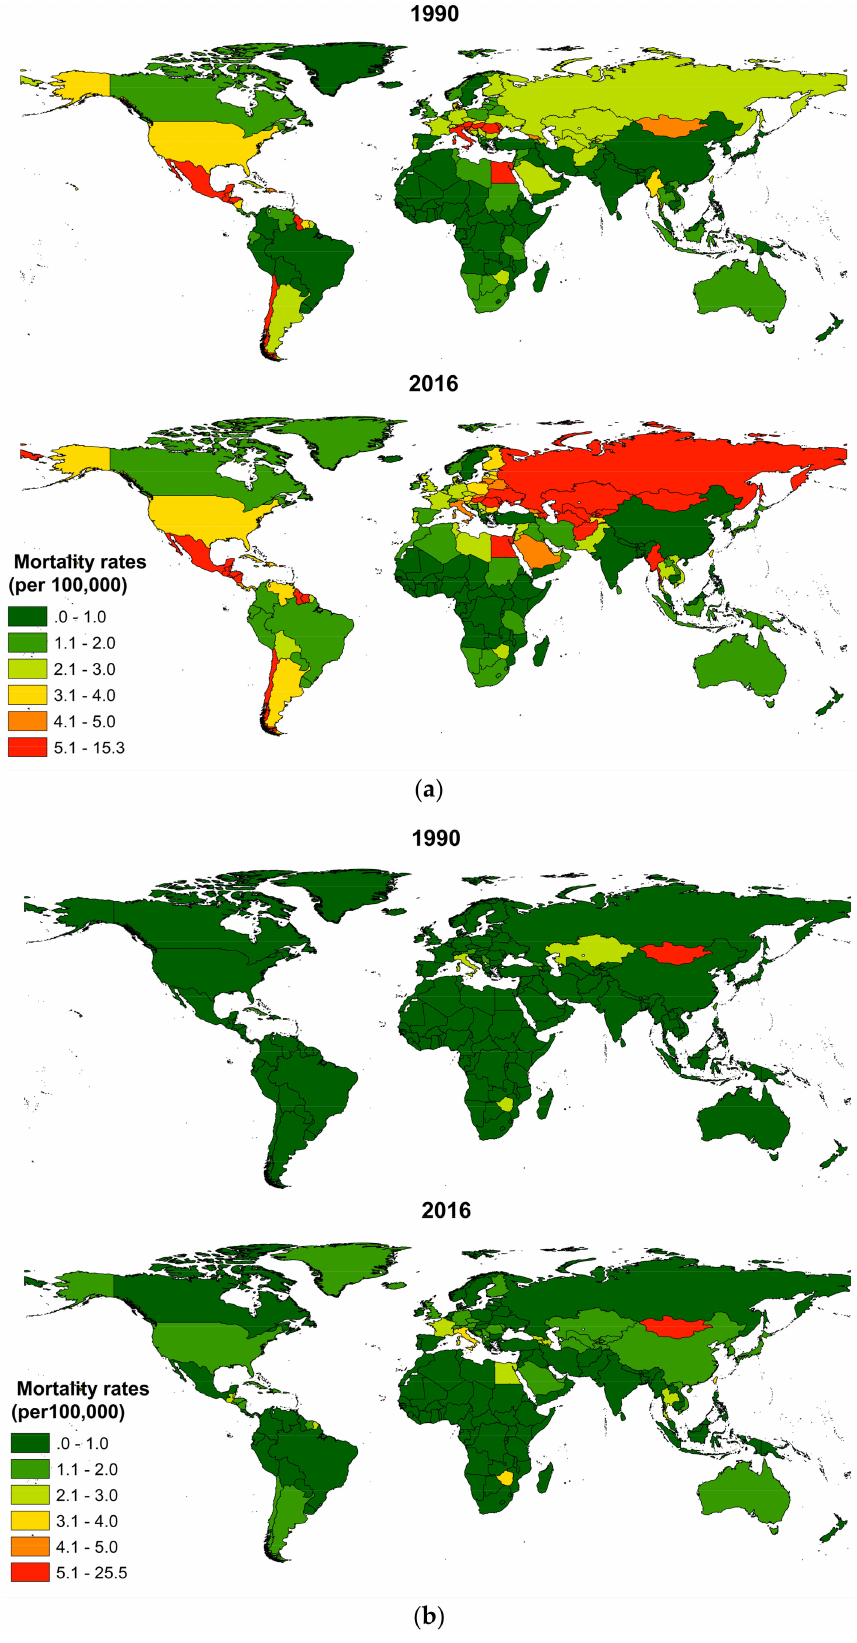
Figure 6. Mortality rates (age-standardized, per 100,000) of ( a ) IDU-attributable cirrhosis and ( b ) IDU-attributable cirrhosis in 1990 and 2016, by